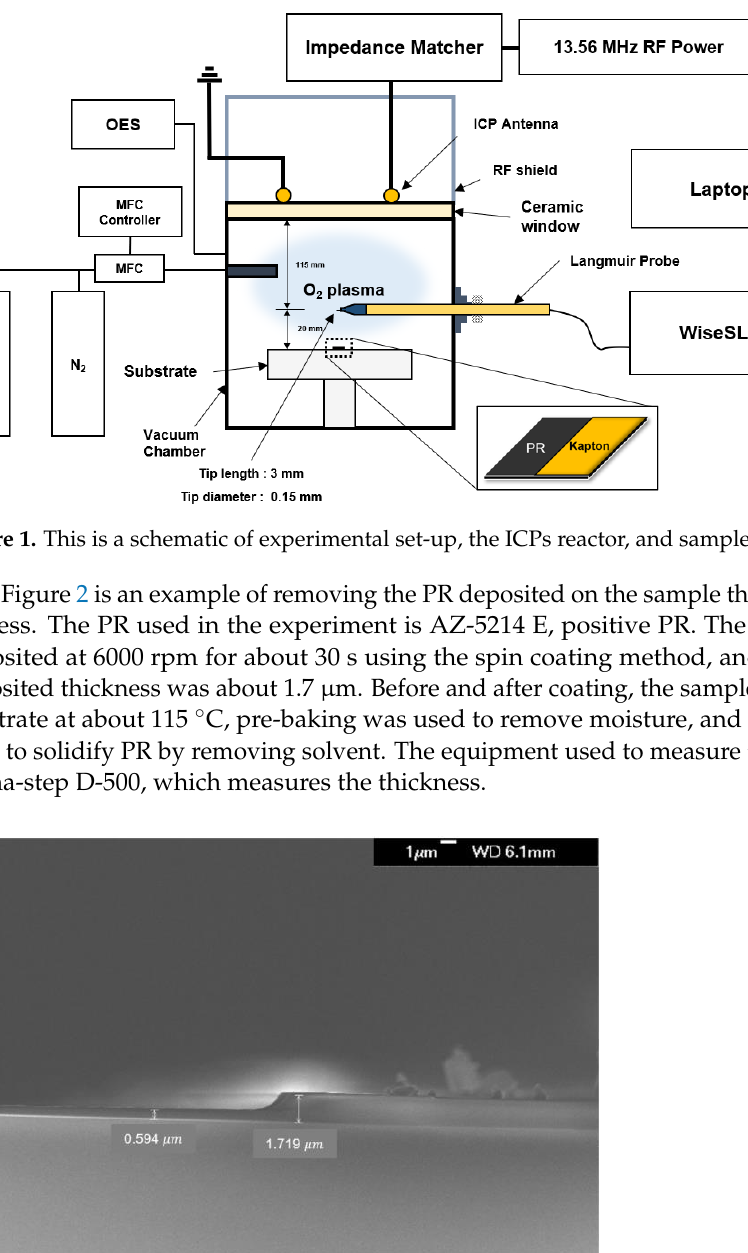
Figure 1. This is a schematic of experimental set-up, the ICPs reactor, and